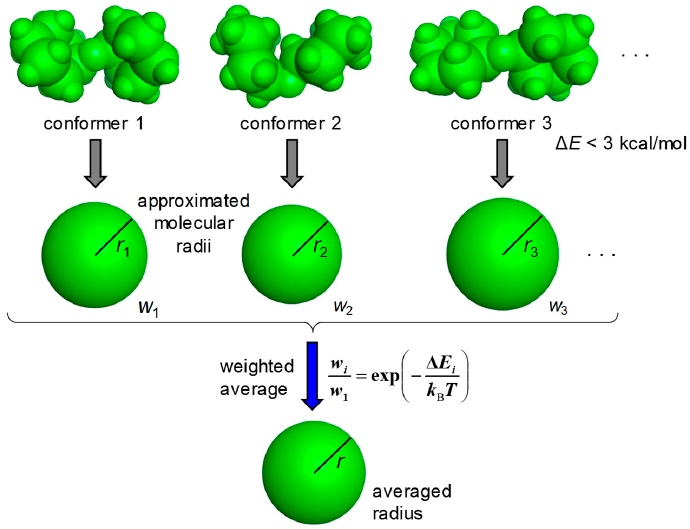
Figure 1. Derivation of the average radius of a molecule. Molecular radii are approximated for the stable conformations with Δ E < 3 kcal/mol, and the average radius is then derived as a weighted average of those. Based on Δ E i , the weight ( w i ) is calculated by the Boltzmann distribution at a temperature of 298 K.